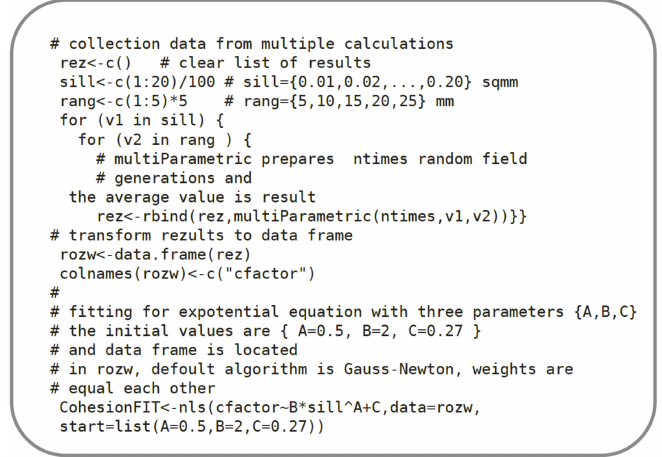
Figure 13. Algorithm No. 3 in R language. Nonlinear least squares (NLS) estimates of the s parameters. NLS use as a default the Gauss–Newton